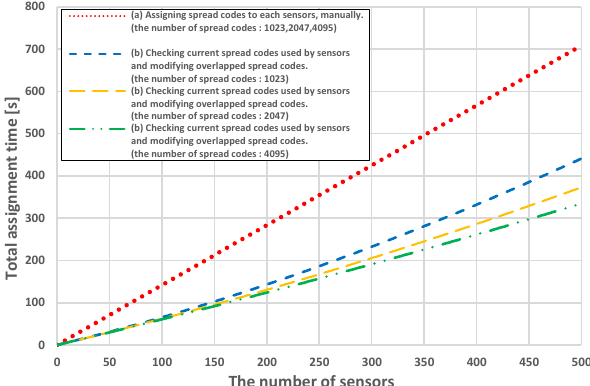
Figure 6. Relationship between the number of sensors and total assignment time for different methods and numbers of spread codes.